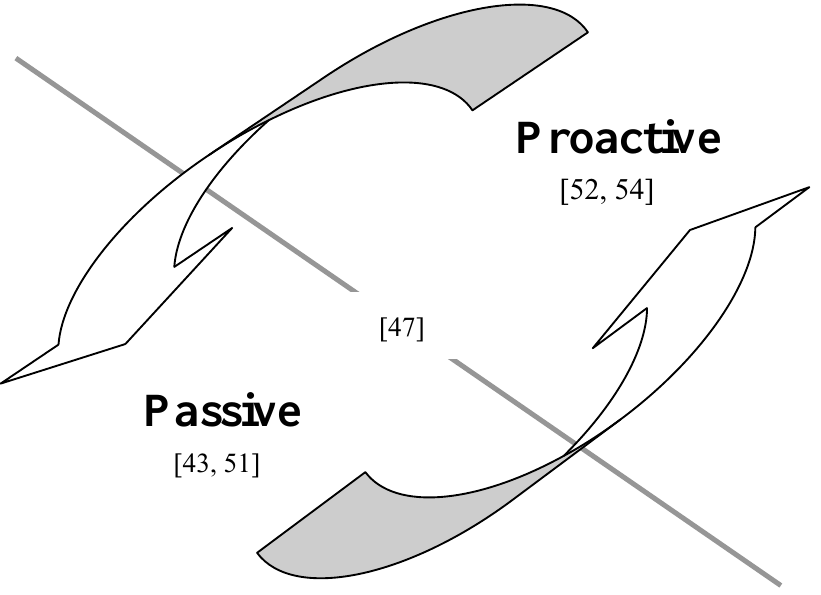
Figure 2. Classifications of Web Mashup User